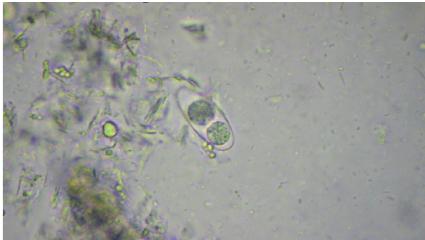
Figure 5: Cryptosporidium oocysts appearing as unstained struc- tures on modified trichrome stain, under oil immersion.